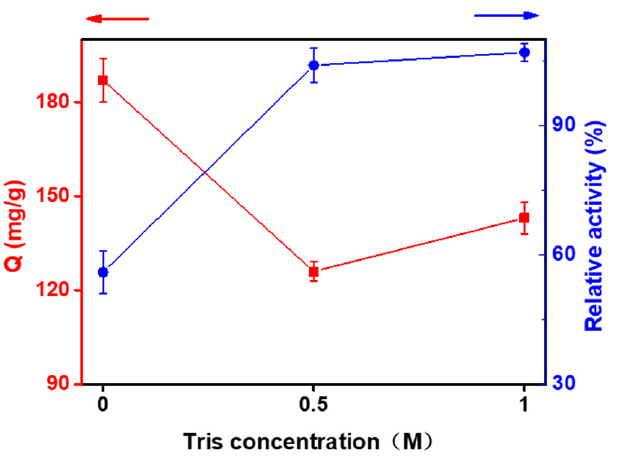
Figure 3. Effect of Tris-HCl on the capacity and activity of immobilized enzyme.